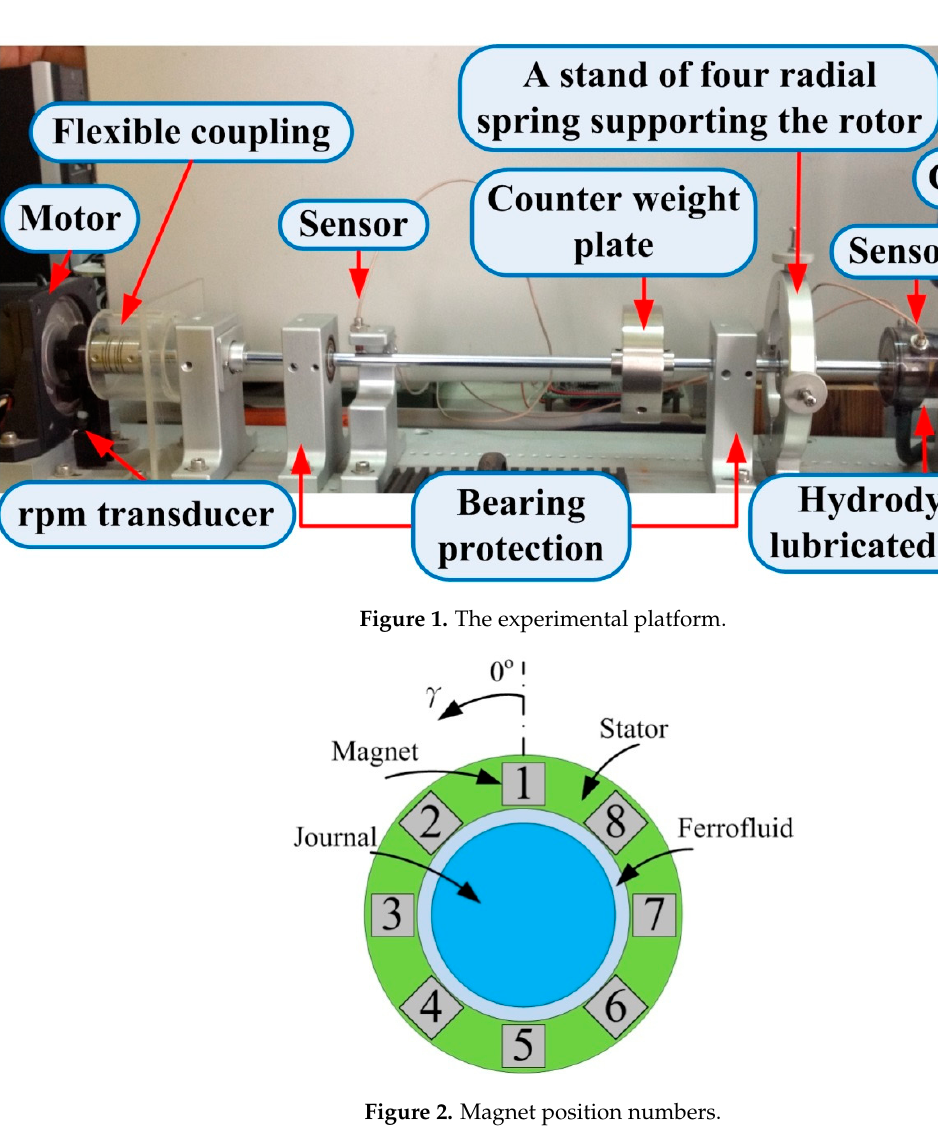
Figure 2. Magnet position numbers.